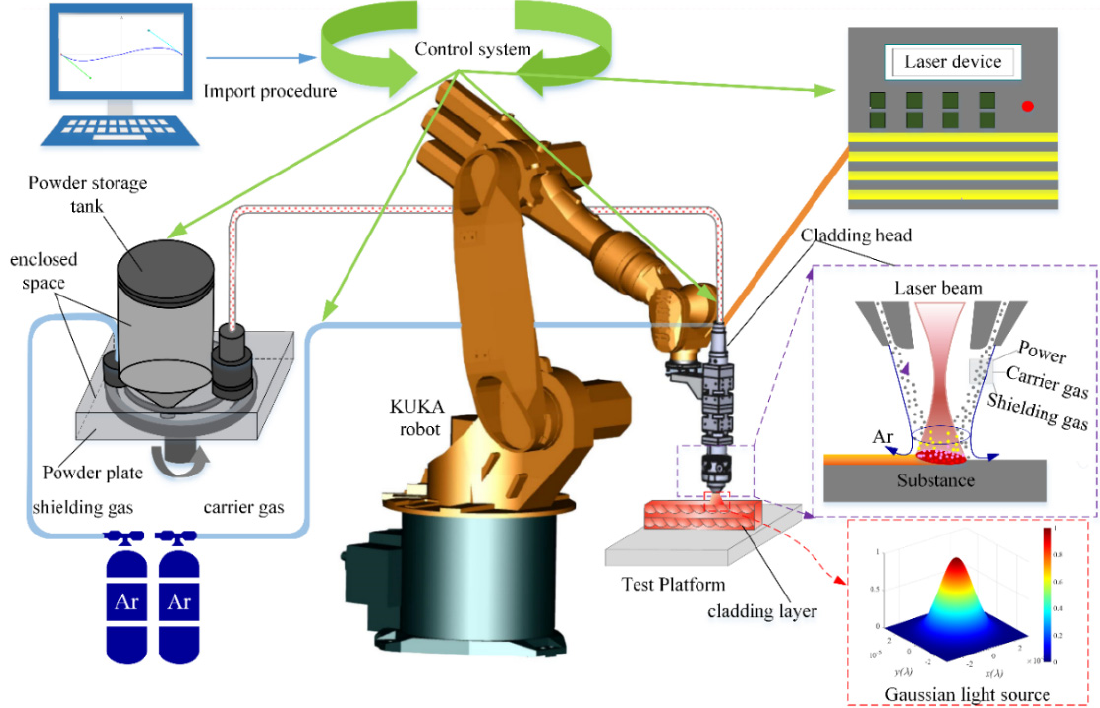
Figure 2. The schematic diagram of the LC experiment device.